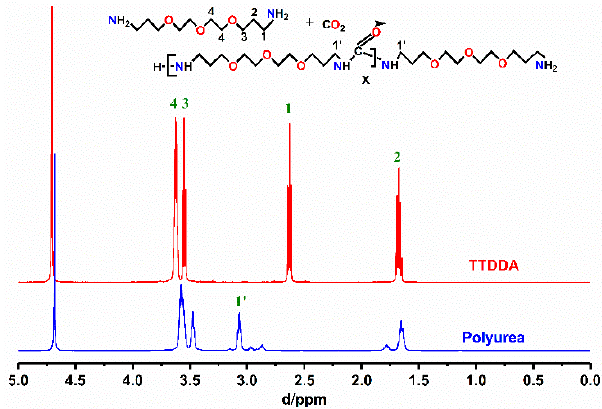
Figure 1 . 1 H-NMR spectrum of polyurea and TTDDA.